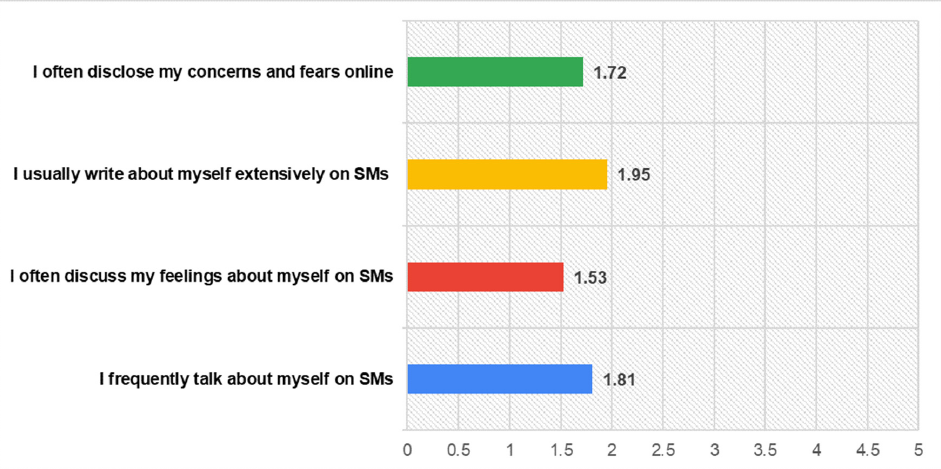
Figure 3. Self-disclosure.